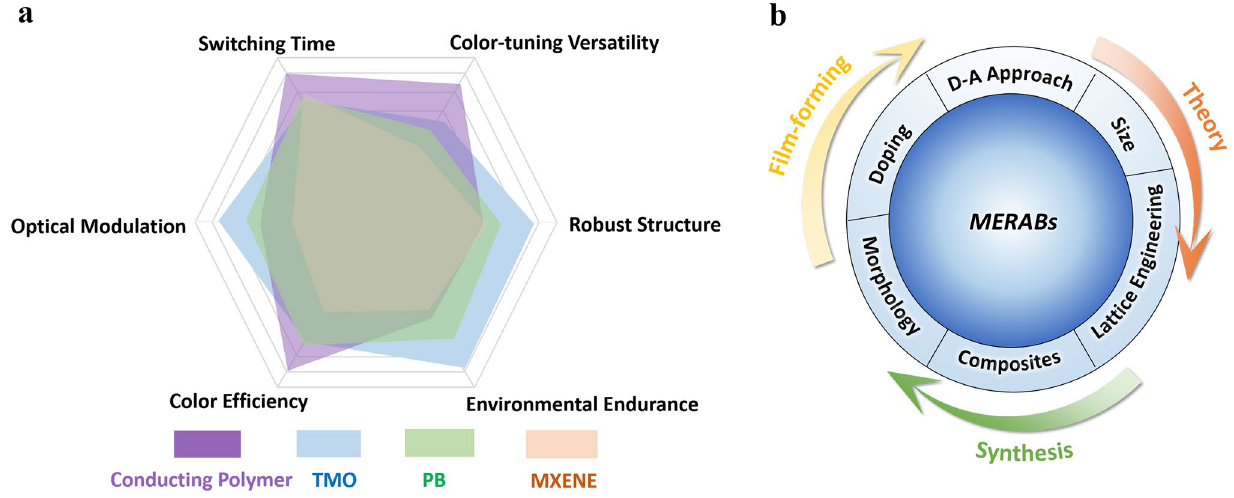
Fig. 6 Comparison of typical MERABs materials and main modified strategies. a Summary of the typical characteristics of different MERABs materials. b Schematic diagram showing the main strategies for improving electrochemical and electrochromic performances of